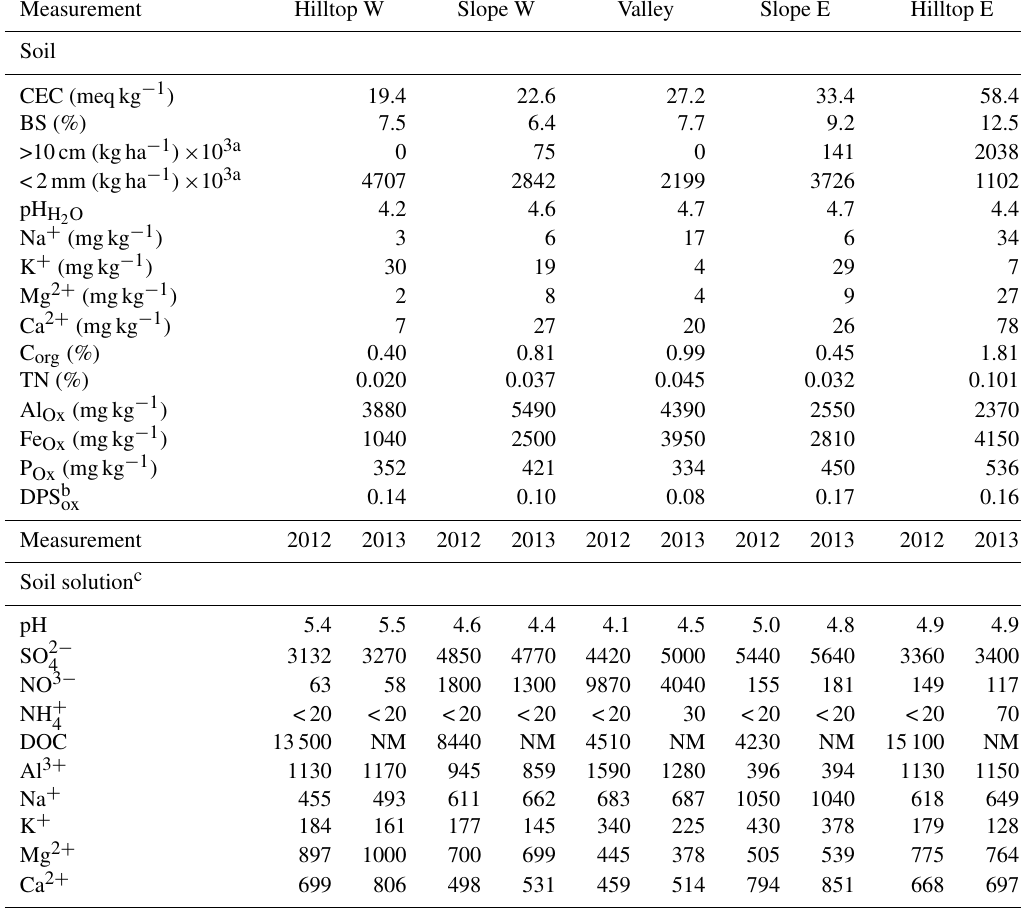
Table 2. Spatially resolved physical and geochemical data for solid substrate (40–80cm depth) and annual average soil solution chemistries at the 50cm